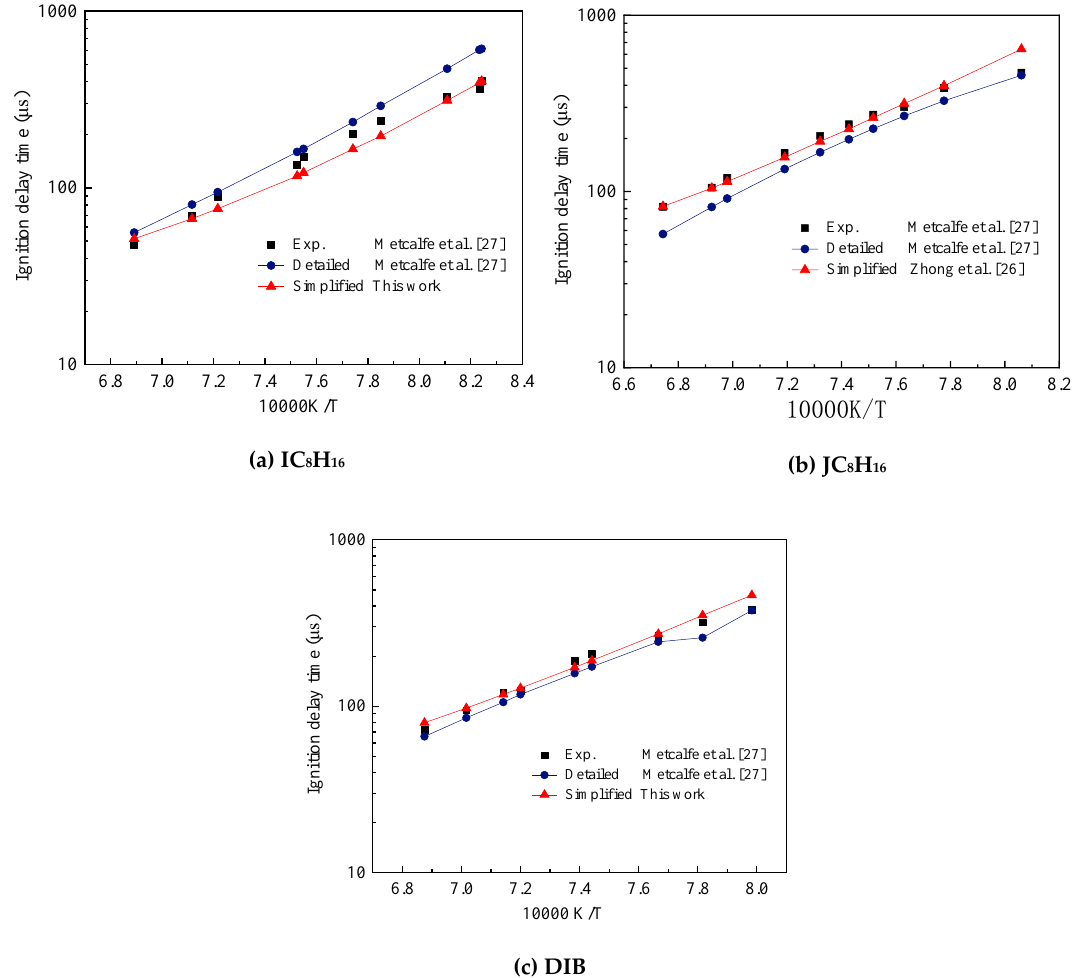
Figure 11. Comparison of experimental and diisobutylene (DIB) submechanism validation results on ignition delay times, ( a ) IC 8 H 16 , ( b ) JC 8 H 16 and ( c )